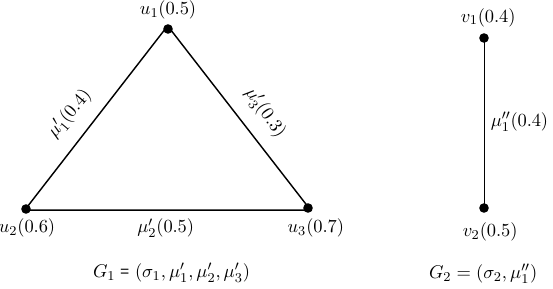
Figure 3: Two Fuzzy Graph Structures G 1 and G 2 Figure 3. Two fuzzy-graph structures G 1 and G 2